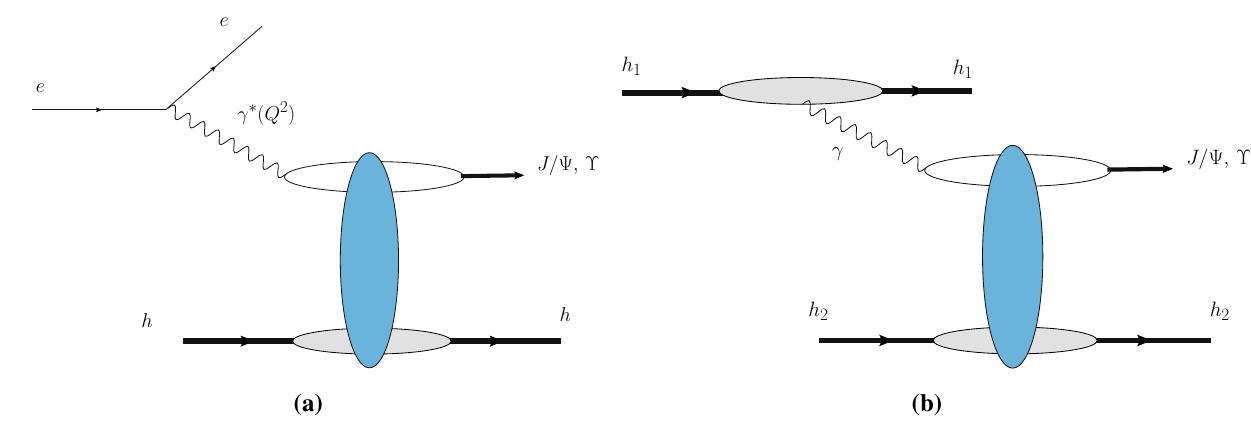
Fig. 1 Exclusive vector meson photoproduction in a electron–hadron and b ultraperipheral collisions